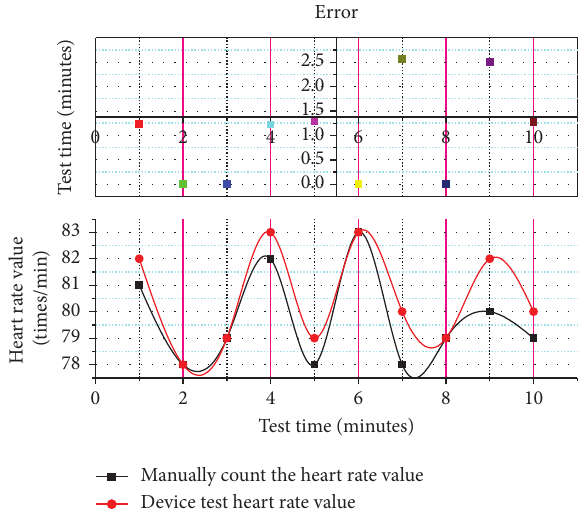
Figure 4: Device heart rate test